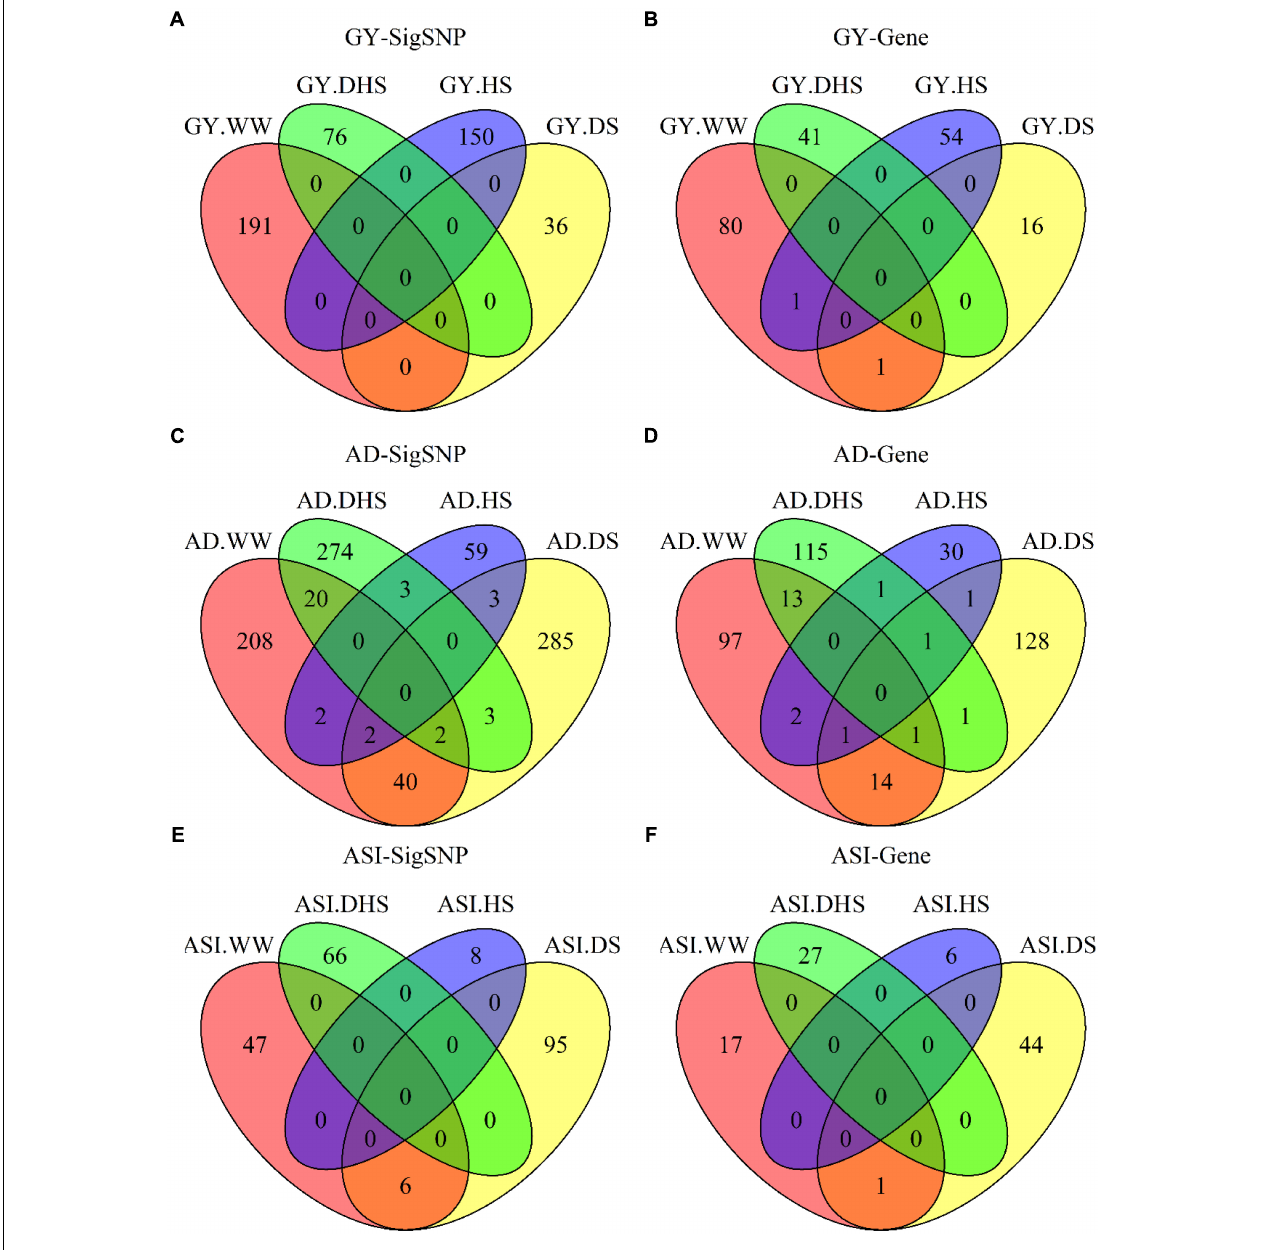
FIGURE 4 | The number of overlapping SNPs (A,C,E) and candidate genes (B,D,F) for each trait evaluated under different conditions. GY, AD, and ASI indicate grain yield, anthesis date, and anthesis–silking interval, respectively. WW, DS, HS, and DHS are abbreviated from well-watered, drought stress, heat stress and combined drought and heat stress management